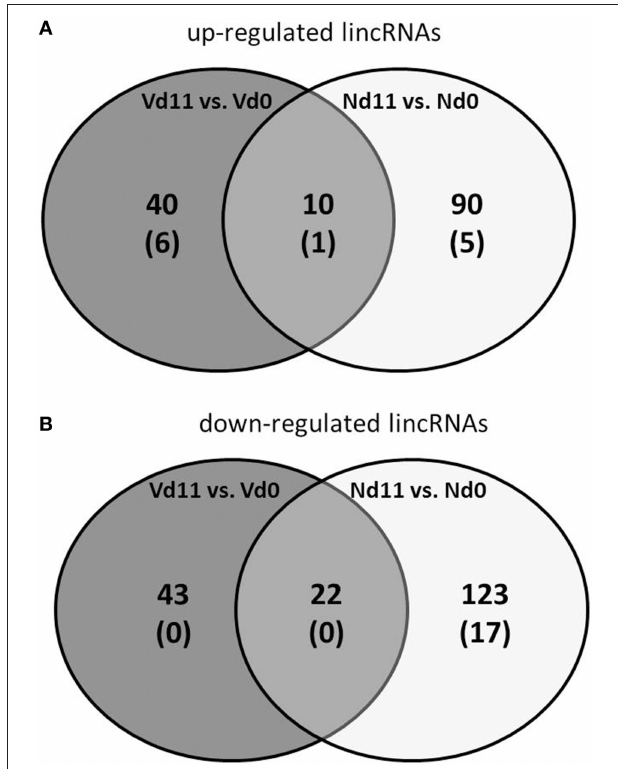
FIGURE 4 | Number of up-regulated (A) and down-regulated (B) lincRNAs expressed more than 3-fold ( p < 0.01) in the liver of non-vaccinated (N) and vaccinated mice (V) infected with P. chabaudi on day 11 p.i. as compared to constitutive expressions on day 0 p.i. (Nd11 vs. Nd0 and Vd11 vs. Vd0). Numbers in brackets indicate lincRNAs expressed more than